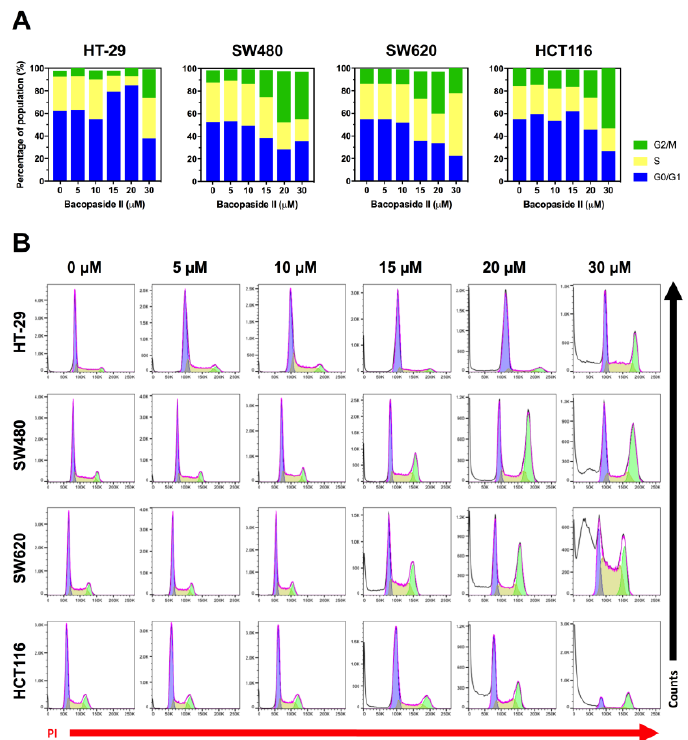
Figure 4. Effect of bacopaside II on cell cycling. Cells were treated with bacopaside II for 24 h, the DNA was stained with propidium iodide, and analysed by flow cytometry. ( A ) The percentage of population of single cells in G0/G1, S and G2/M phases of the cell cycle. ( B ) Representative histograms of the PI stained DNA, showing the subG1 events (white), G0/G1 (blue), S (yellow) and G2/M (green). Results shown are representative of 3 repeated experiments.